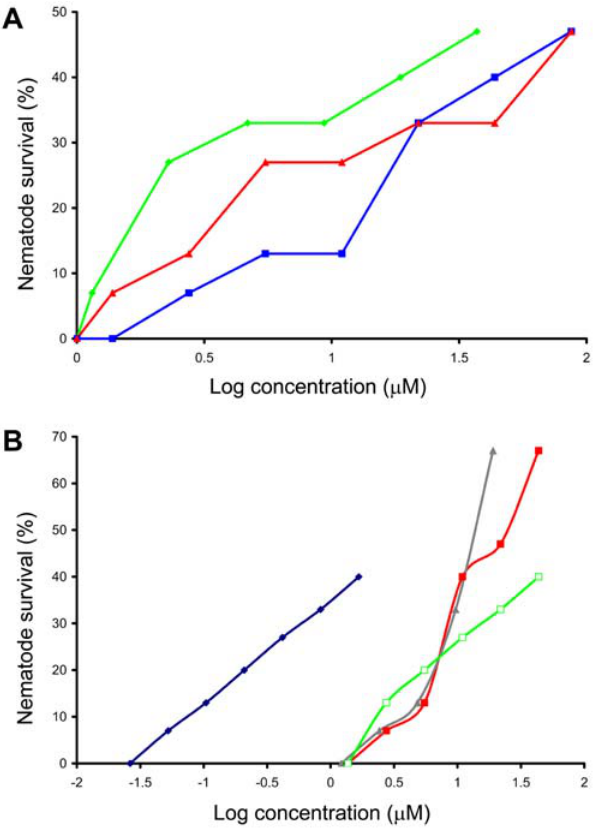
Figure 4. Survival of C. albicans -infected nematodes in the presence of seven compounds identified in the C.elegans – C. albicans ‘‘curing’’ assay. (A) Nematode survival in the presence of the three immunosuppressive compounds: ascomycin (green), cyclosporine A (red), and FK-506 (blue); (B) Nematode survival in the presence of four other compounds identified in the screen which demonstrated antifungal activity: concanamycin A (blue), dequalinium chloride (gray), triadimefon (red), and phenylmercuric acetate (green).